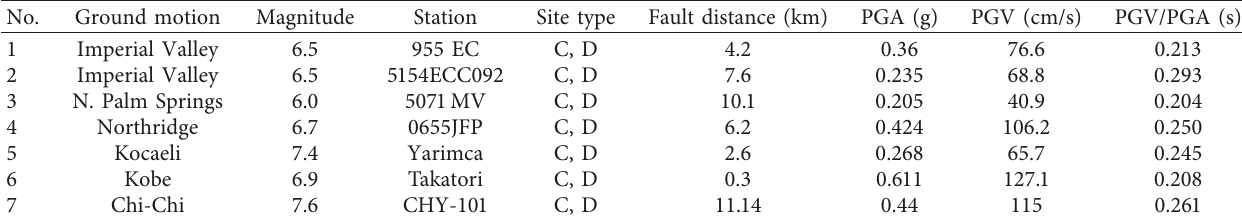
Figure 3: Acceleration spectrum of the selected ground motions. Table 2: Parameters of near-field seismic recording.